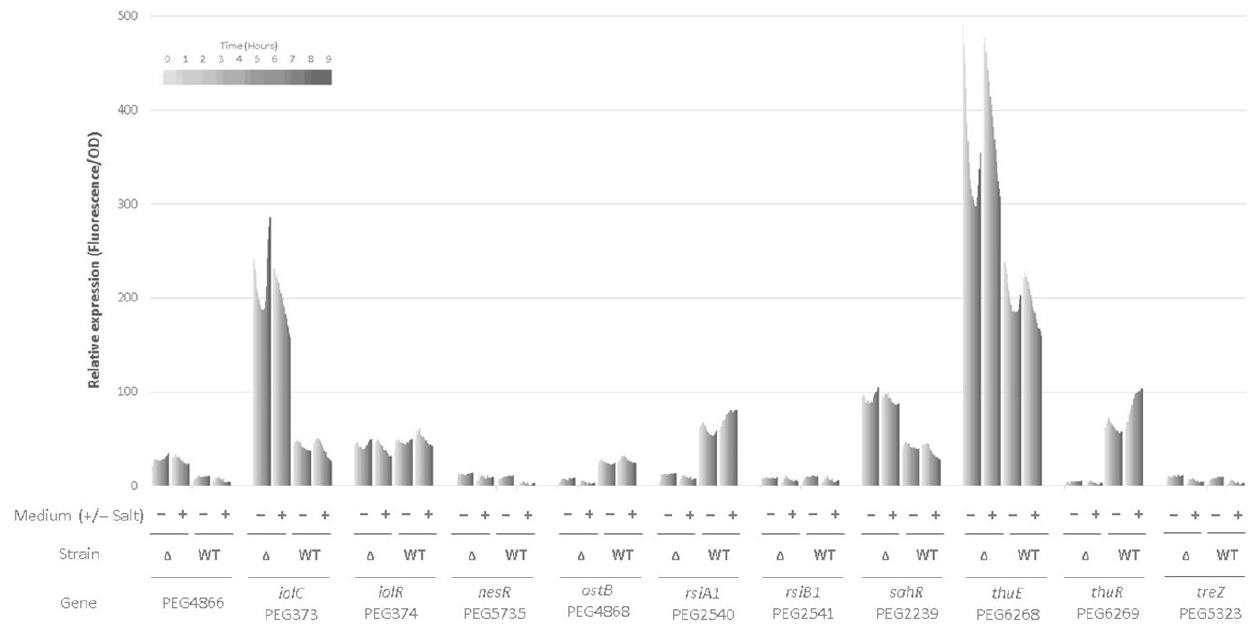
Figure 3. Effect of the rpoE2 mutation on transcriptional activity of selected genes. The histograms show the relative expression (see Materials and Methods) of gfp under the control of promoters from selected genes mobilized in wild-type Ensifer aridi LMR001 (WT) or the ∆ rpoE2 derivative ( ∆ ) strains grown in TY medium containing salt (NaCl at 250 mM) or not (+/ − ), as indicated at the bottom of the figure. Relative expressions were recorded every 30 min for 9 h and are shown by gray bars of increasing darkness with time (colors indicated on the top left of the figure).